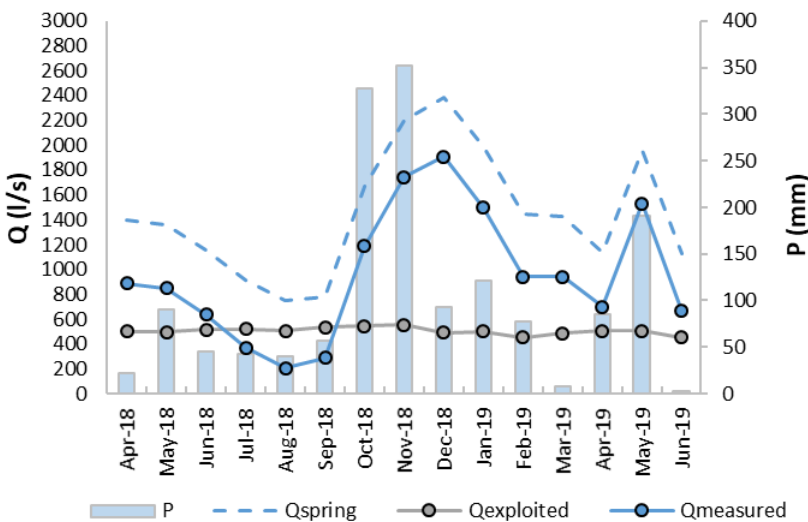
Figure 3. Comparison between the monthly rainfall trend and the flow rates exploited and supplied by Capodacqua di Spigno Spring. The monthly discharge values were reported at the half of each month by using the interpolation method.